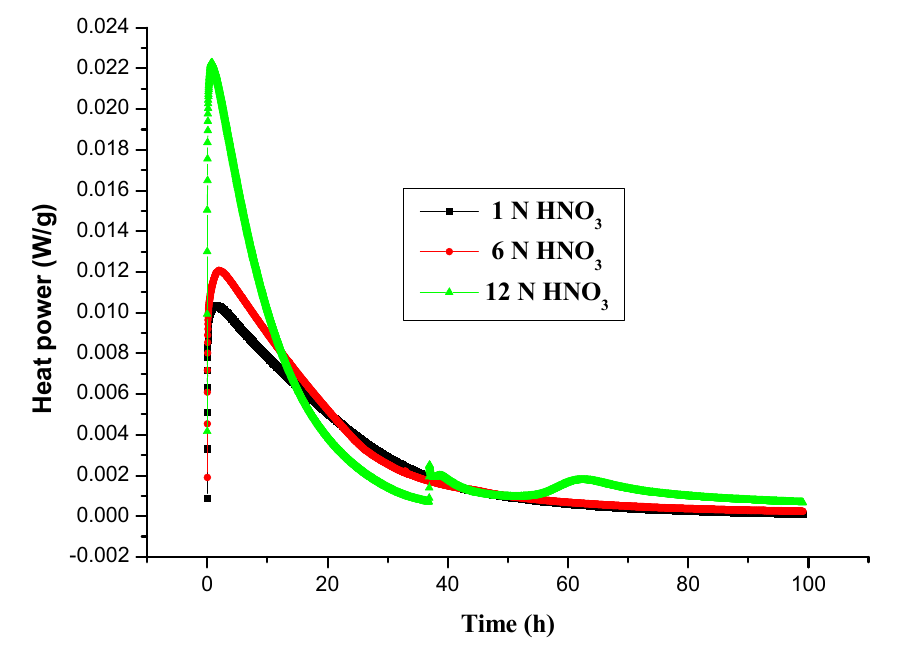
Figure 2. Heat flow vs. time for the thermal decomposition of 95 mass% LPO with 1, 6, and 12 N HNO at 60 °C by TAM III 3